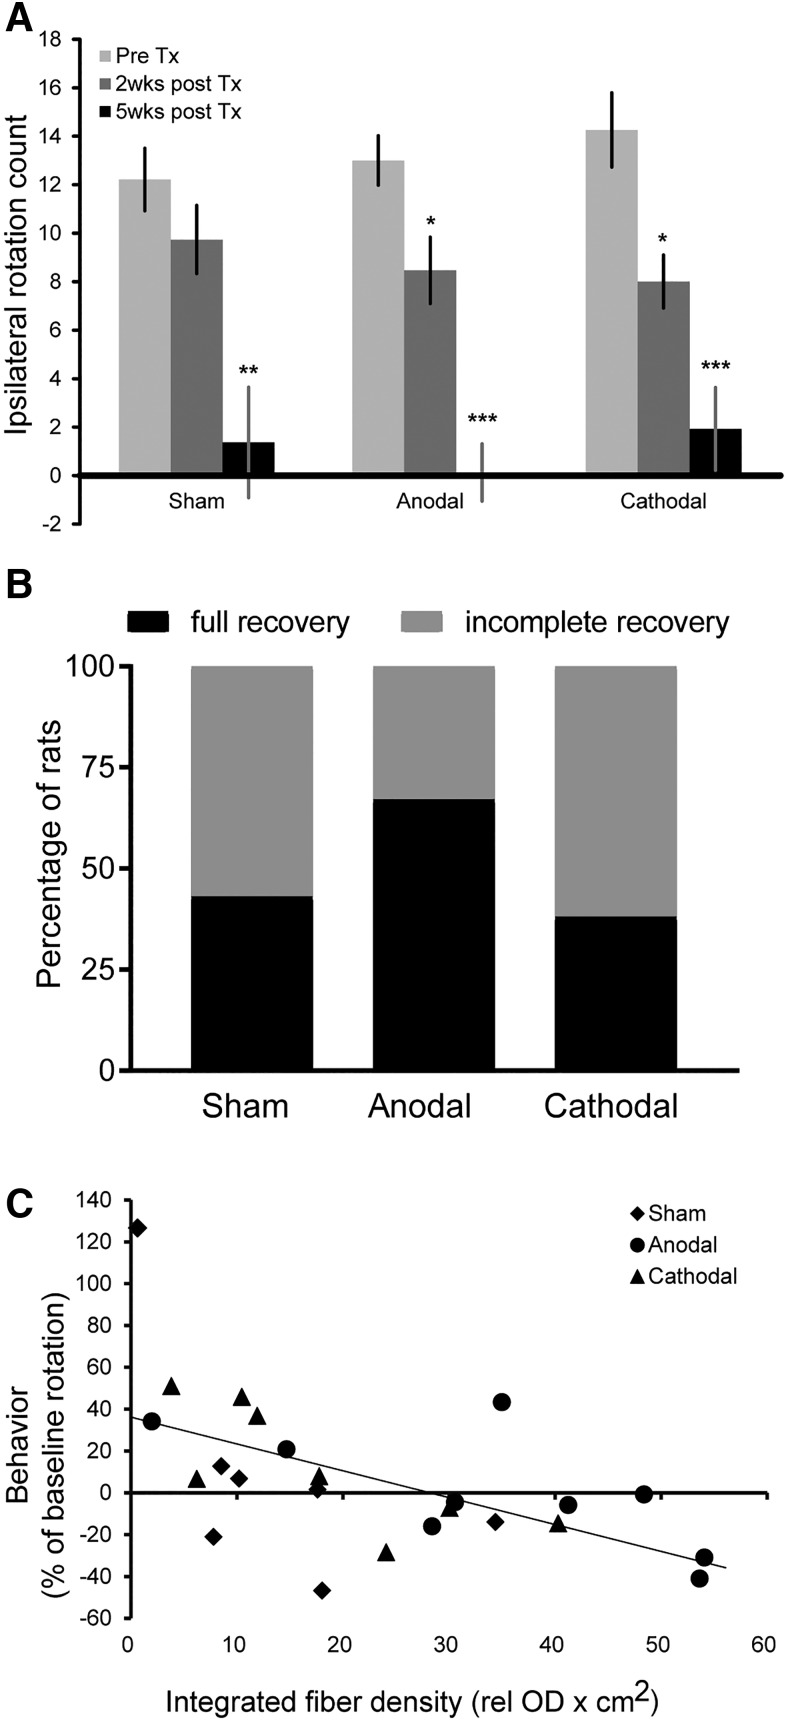
Behavioral recovery was more pronounced following anodal transcranial DCS, and behavioral effects correlated with the degree of striatal reinnervation. A, Anodal and cathodal stimulation led to a significant decrease of amphetamine-induced ipsilateral rotation two weeks after transplantation; this effect was not seen with sham DCS. By five weeks, all groups showed significant resolution of ipsilateral rotations. B, Animals in the anodal DCS presented the highest amount of animals with full behavioral recovery, measured as lack of ipsilateral rotation or even contralateral rotation after amphetamine application. C, Generally, larger TH-fiber outgrowth was associated with improvement of baseline rotation five weeks after transplantation. Mean ± SEM. Repeated measure ANOVA, two- and five-week data in each group versus pretransplantation; *p < 0.05; **p < 0.01; ***p < 0.001.